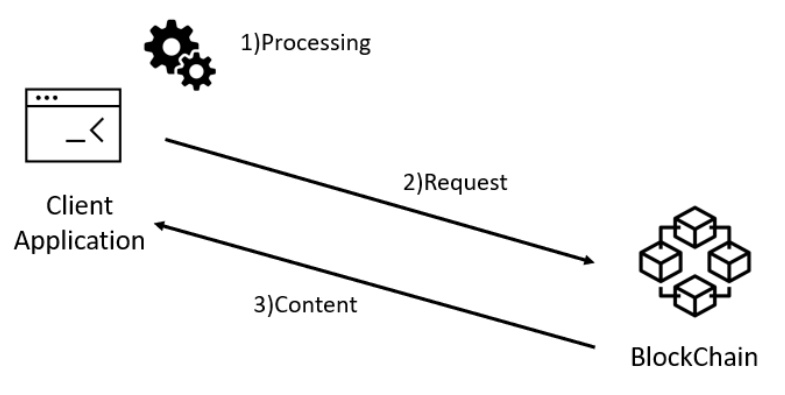
Figure 6. Query flow in BlockProof.